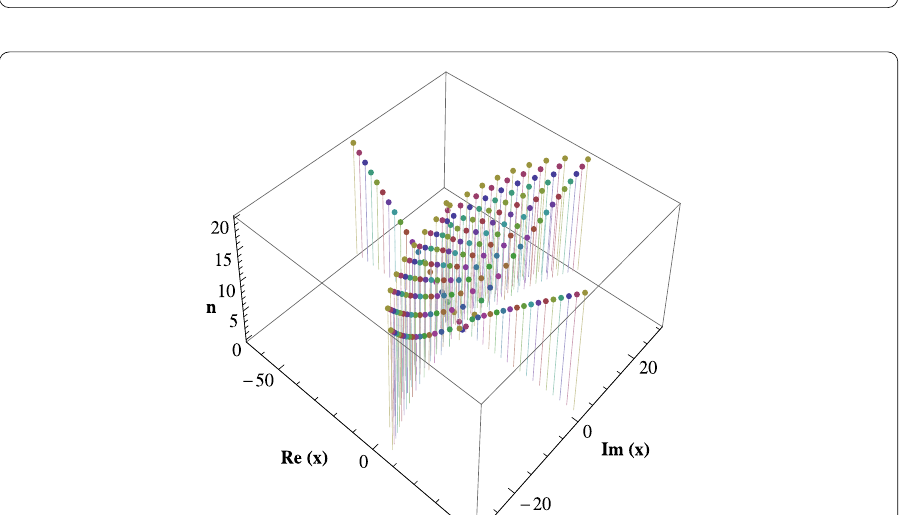
Figure 6 Stacks of zeros of GHFP